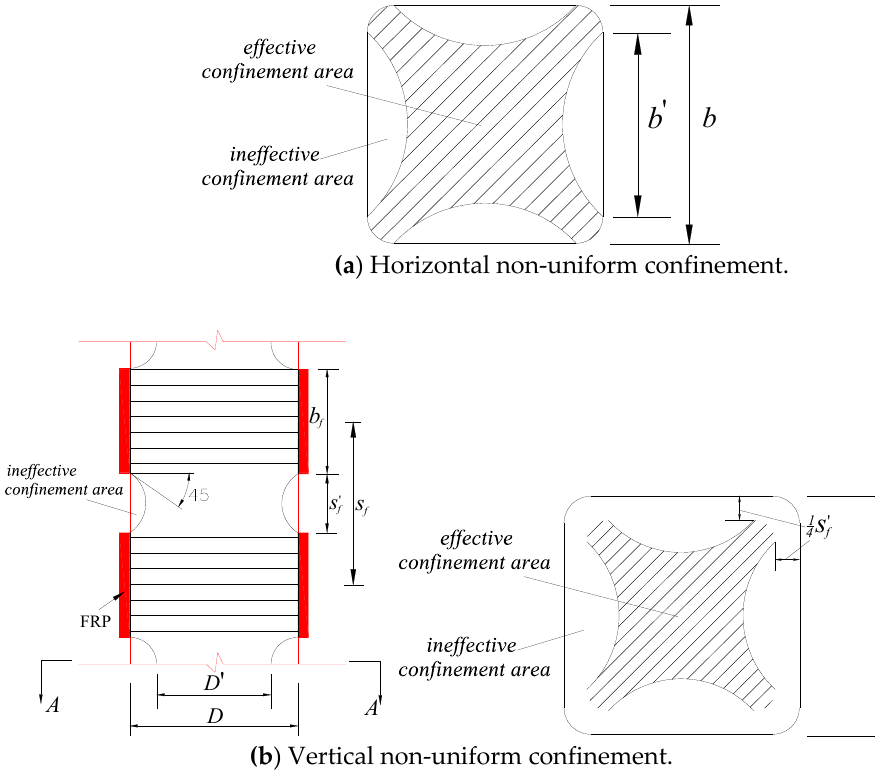
Figure 2. Non-uniform confinement in square columns partially wrapped with FRP strips.